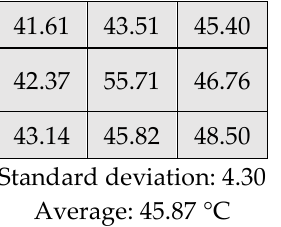
Figure 9. The heat source temperature uniformity of 30 mL/min HTF flow rate and 15 W power rate for ( a ) one-layer; ( b ) two-layers; ( c ) three-layers MLM heat sink; ( d ) Schematic of the thermocouple distribution on heat source surface.